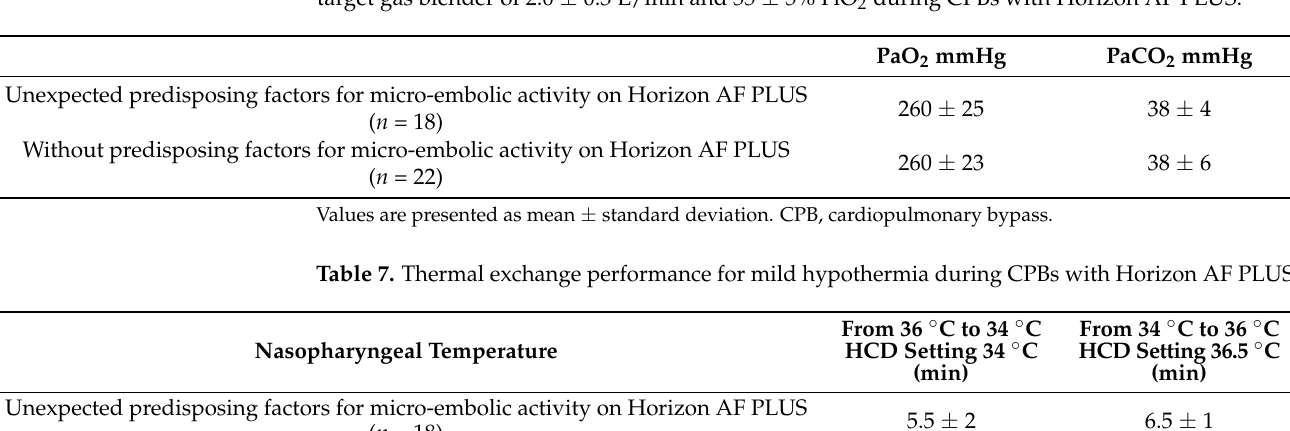
Table 6. Evaluation of oxygenation performance in terms of mean values of PaO 2 and PaCO 2 for the